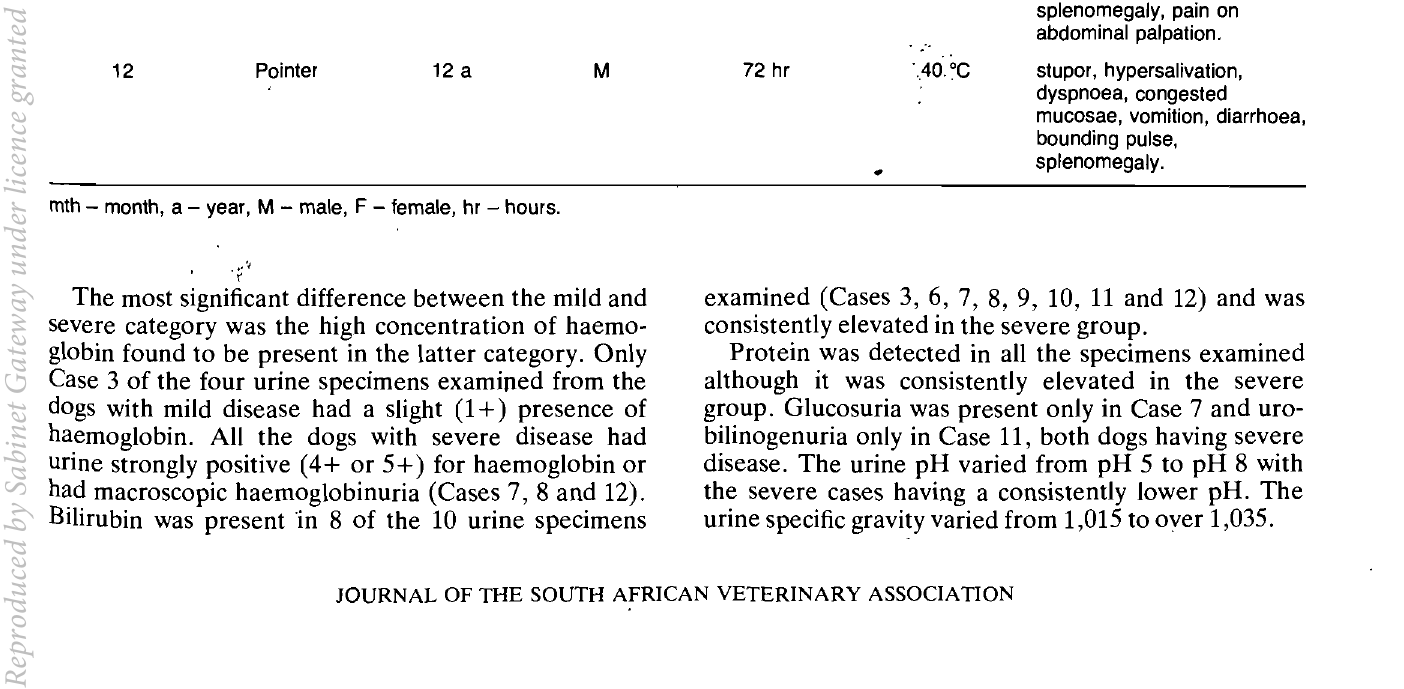
Table 2: SIGNIFICANT CLINICAL FEATURES OF SEVERE